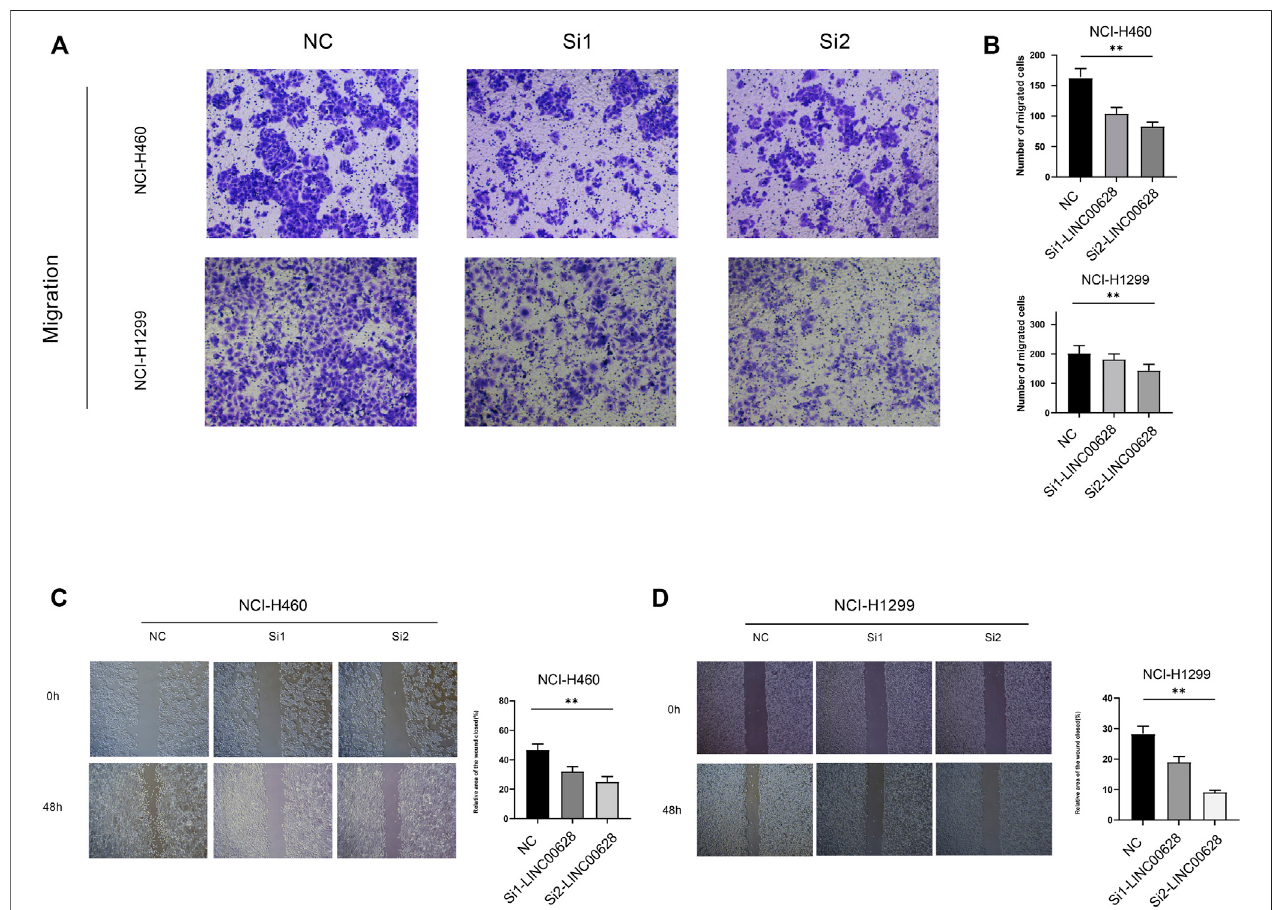
FIGURE6|(A,B) Transwellassayofsi1-LINC00628 and si2-LINC00628 groups. (C,D) Wound healingassayofsi1-LINC00628and si2-LINC00628 groups. * p < 0.5, ** p < 0.01, *** p < 0.001, **** p < 0.0001, ns, no signi fi cance.